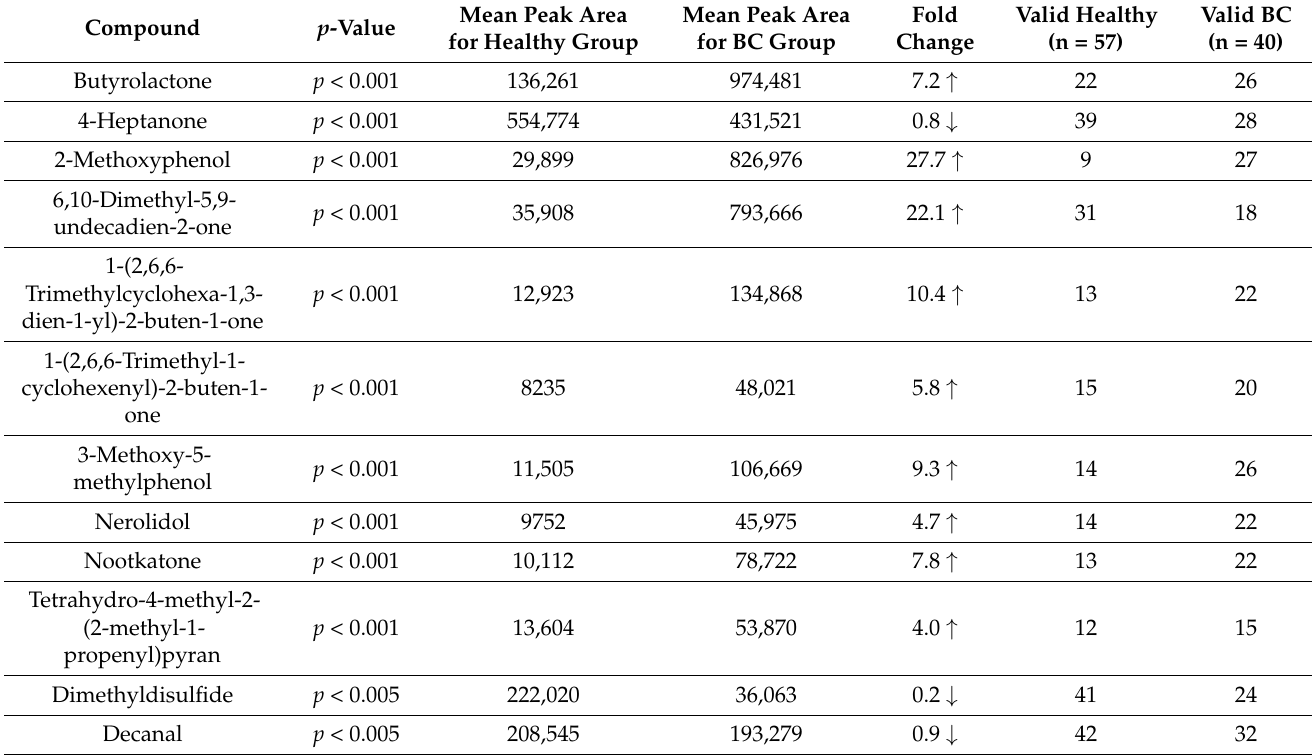
Table 2. Results of the Kolmogorov–Smirnov